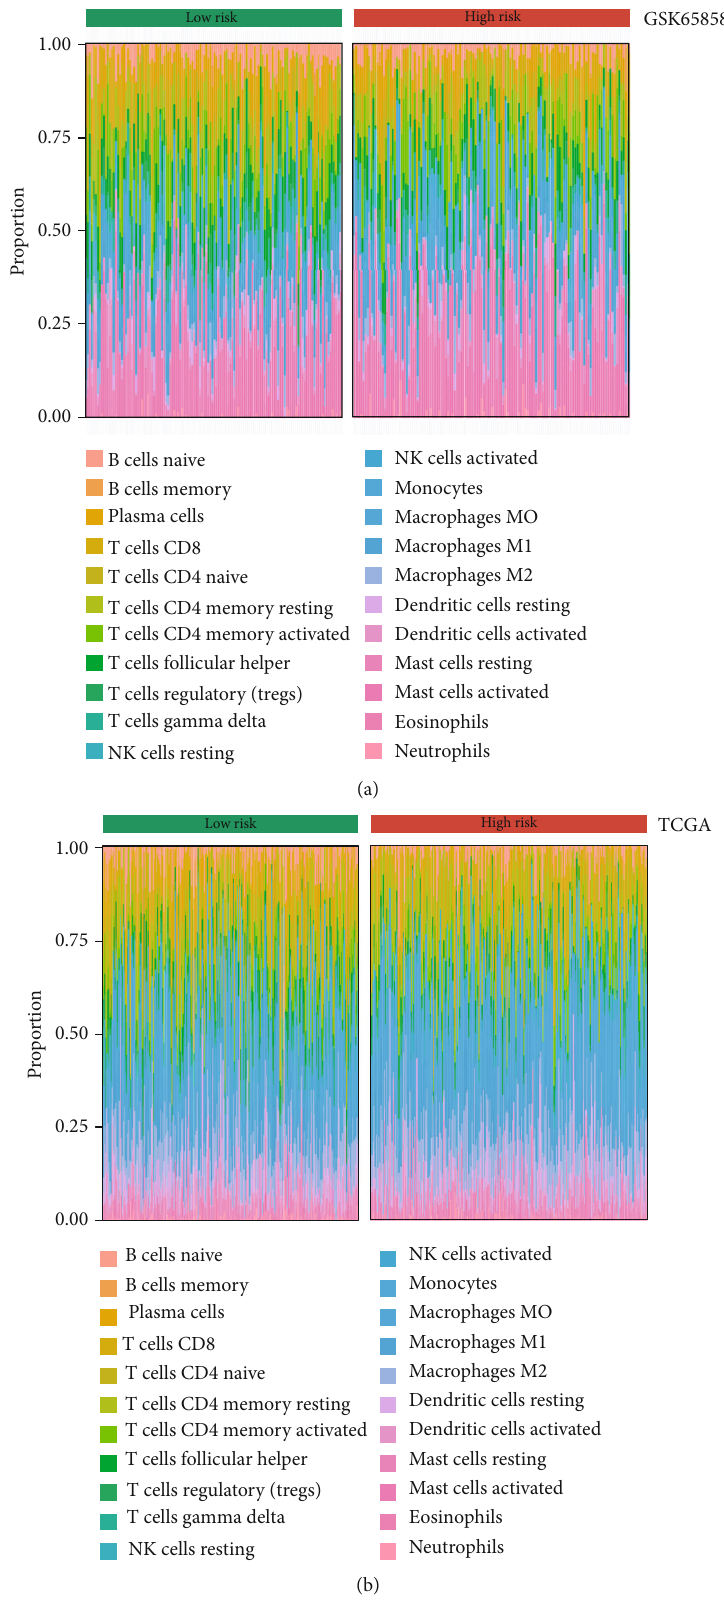
Figure 9: The proportions of immune cell types in HNSCC patients: (a) the mean proportions of 22 immune cell types in the GSE65858 cohort; (b) the mean proportions of 22 immune cell types in the TCGA HNSCC